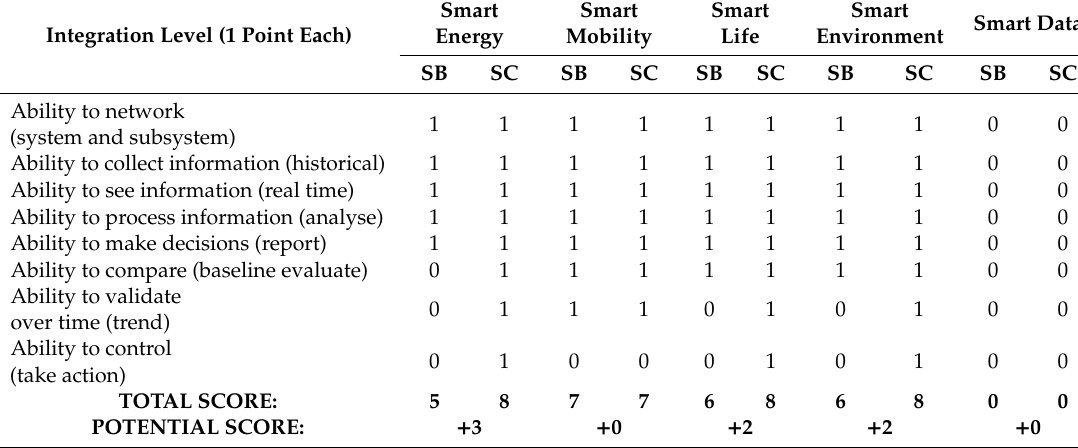
Table 13. Evaluation results of Smart Building (SB) I Integration into Smart City (SC) I.